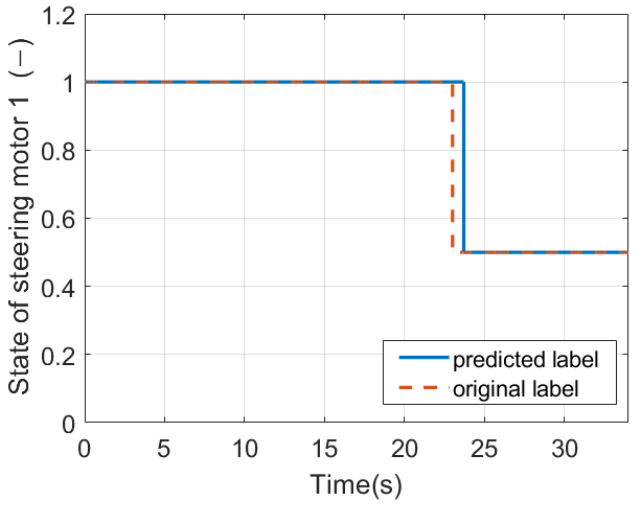
Figure 6. The diagnosis result of the steering actuator 1 (Blue line: the diagnosis result; red dotted line: the original fault